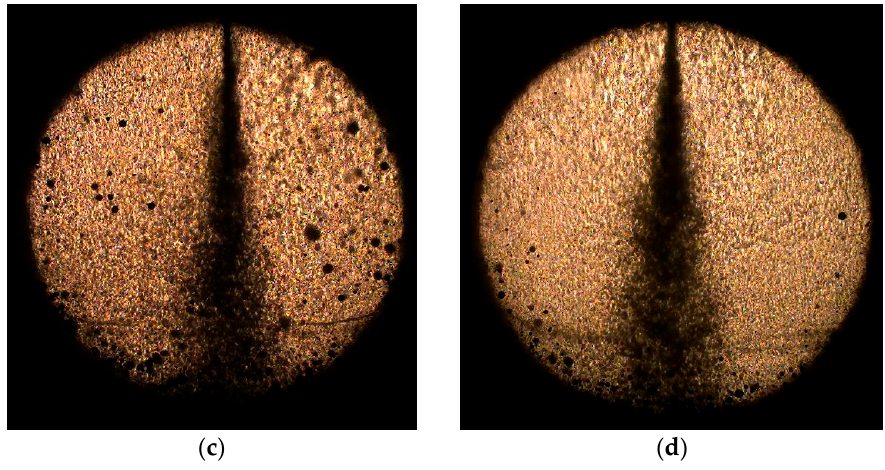
Figure 7. Comparison of effects of water fraction and injection pressure on spray pattern of water- CO 2 mixture: ( a ) 25% at 65/40 bar; ( b ) 75% at 65/40 bar; ( c ) 25% at 85/60 bar; and ( d ) 75% at 85/60 bar.